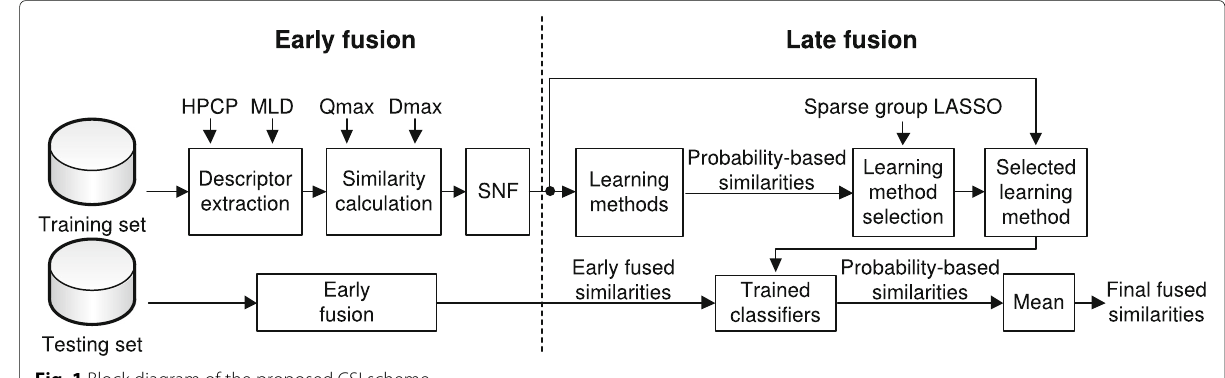
Fig. 1 Block diagram of the proposed CSI scheme